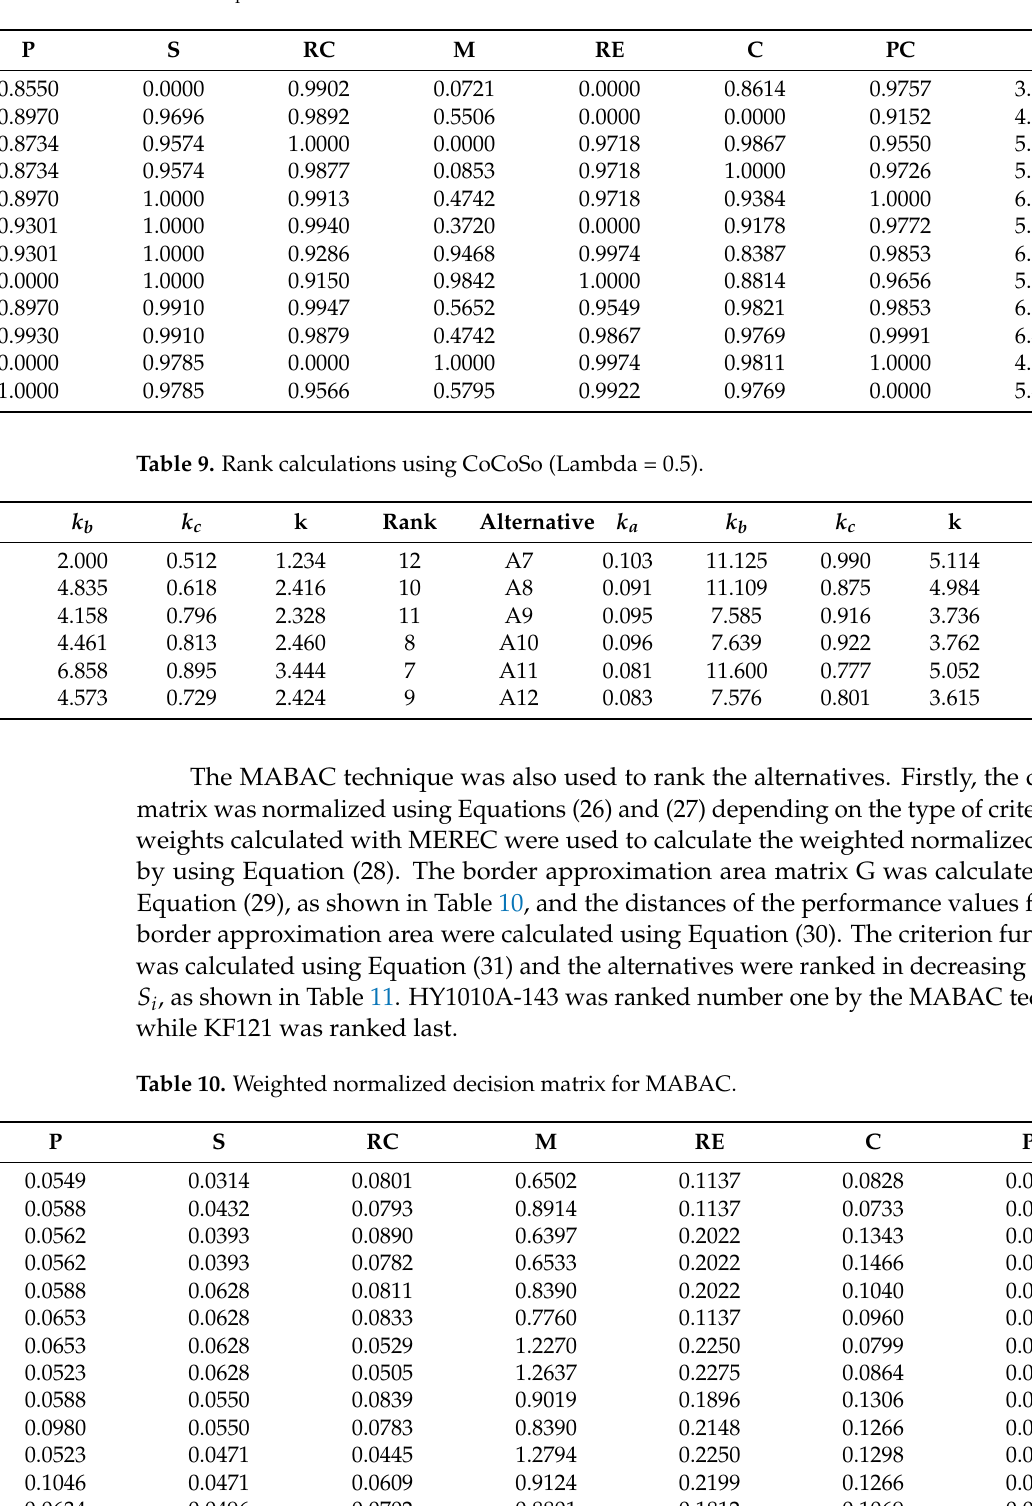
Table 8. P i calculations for CoCoSo.